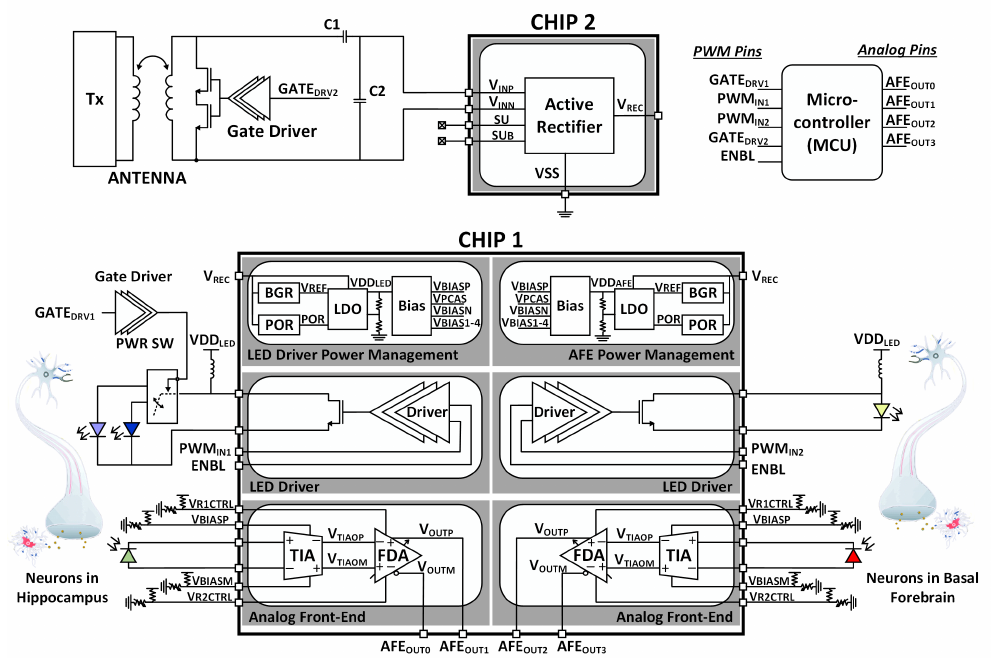
Figure 2. System block diagram.